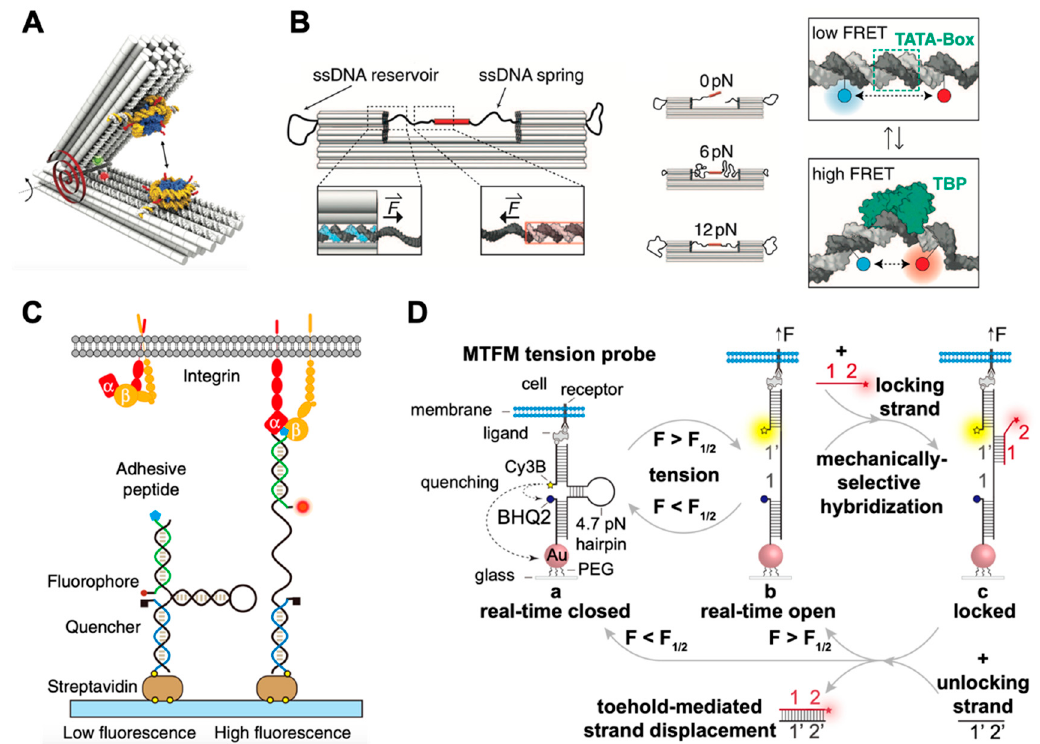
Figure 5. Measurement of molecular forces via DNA nanotechnology. ( A ) Schematic of the DNA force spectrometer featuring a spring-loaded hinge with two attached nucleosomes, reproduced from [111] under terms of the CC BY 4.0 license. ( B ) Structure of the DNA-origami force clamp, with ssDNA reservoirs located on each side of the clamp (left); individual origami samples were assembled for each constant-force variant (middle); TBP-induced DNA bending under force were monitored by FRET (right), adapted with permission from [112]. ( C ) Schematic of the integrin tension sensor, adapted with permission from [115]. ( D ) Schematic depicting the concept of mechanical information storage, adapted from [119] under terms of the CC BY license.